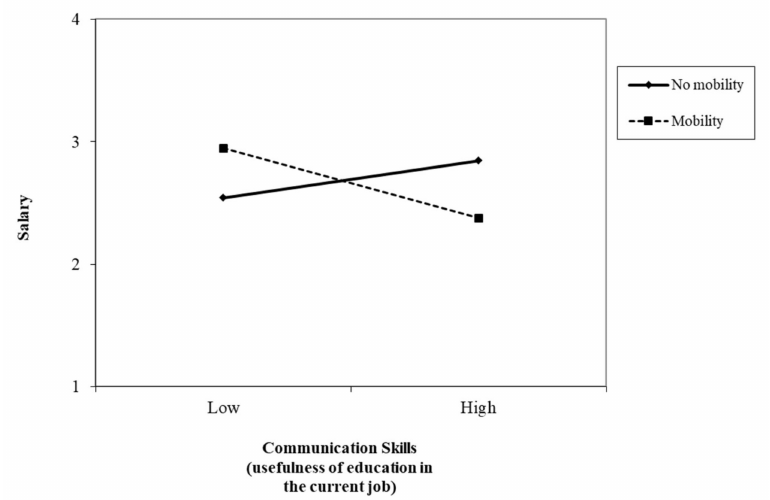
Figure 3. Interaction between communication skills (usefulness of education in the current job) and mobility in predicting